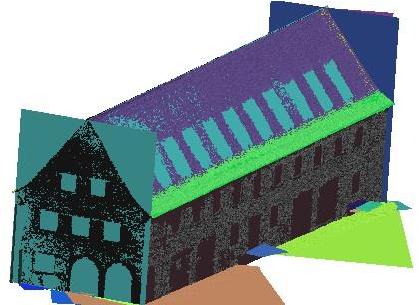
Figure 2. Clustering point cloud to inclusive planes